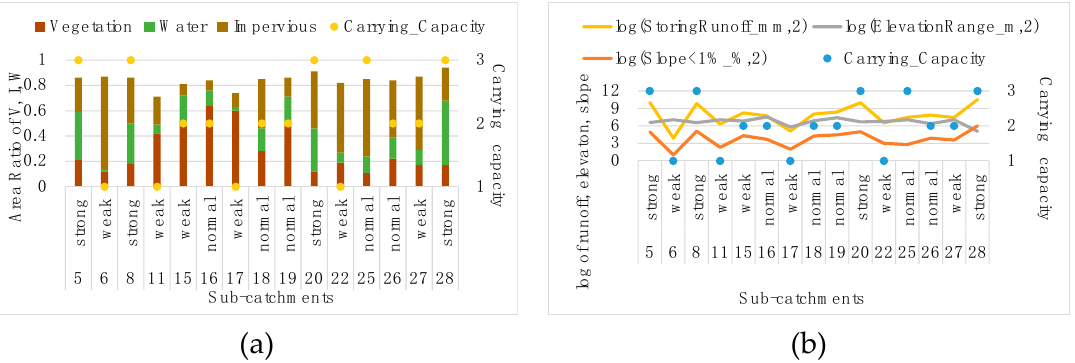
Figure 8. The urban flood-carrying capacity results comparing the factors of land-use type and terrain. ( a ) The comparison of land-use type. ( b ) The comparison of the elevation range of terrain, the slope, and the storing rainwater ability transforming as runoff.